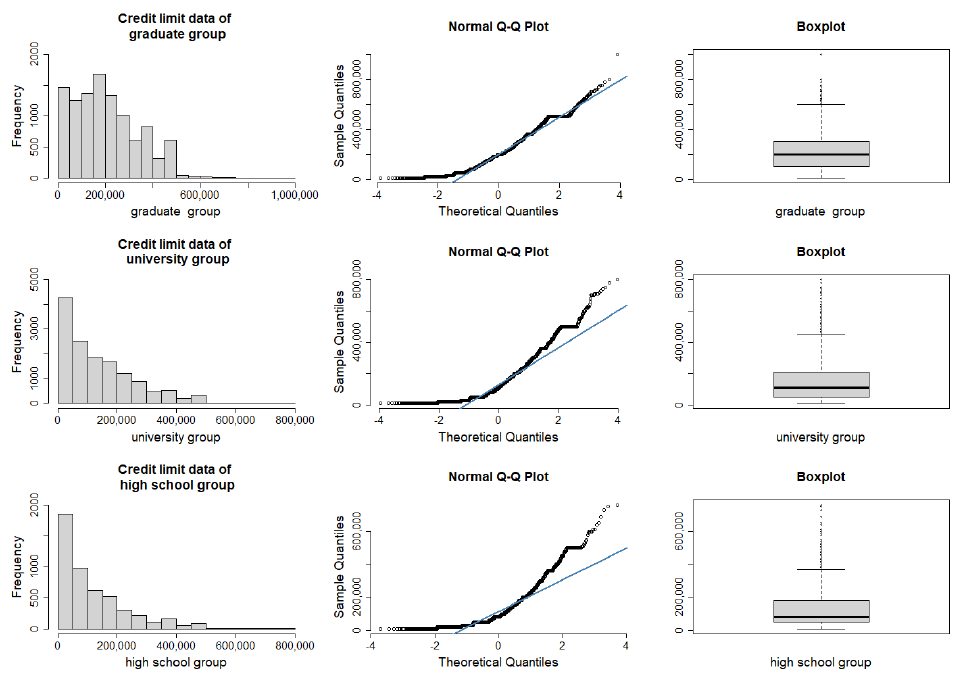
Figure 2. Credit limit data: histograms, normal QQ-plots and boxplots for the graduate ( n = 10,585), university ( n = 14,030) and high school ( n = 4917) student